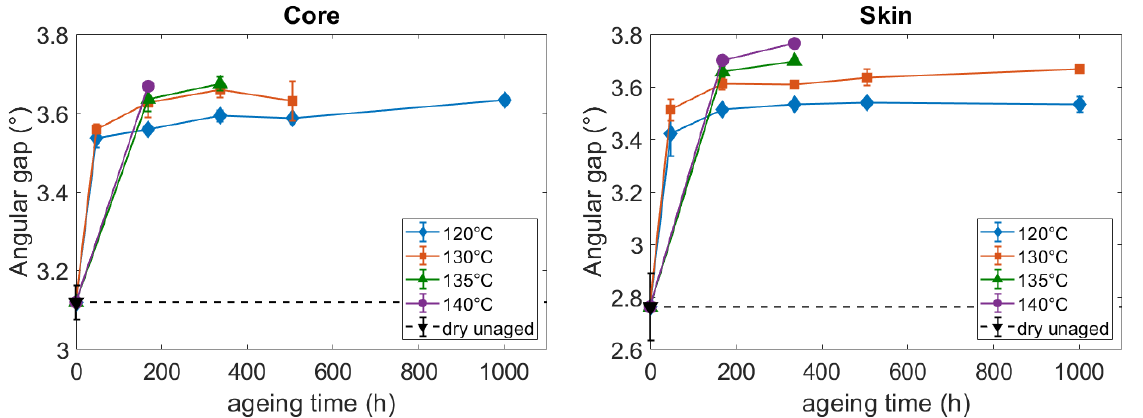
Figure 11. Influence of the aging conditions on the crystal perfection index: the angular gap between the (100) peak and the (010),(001) peak of WAXS diffractograms. The WAXS method was also used to assess the crystallinity of the aged and unaged PA66. A crystallinity index ( χ c ) was defined as the ratio of the area of the crystalline peaks ( A c ) over the total area of the diffractograms, including the crystalline and amorphous contributions ( A a + A c ) (Equation (4)).